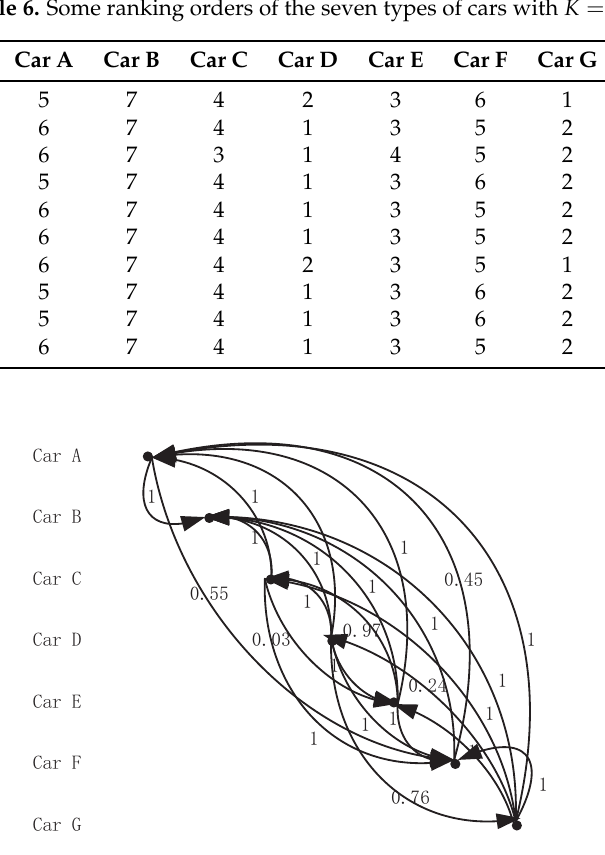
Figure 3. Dominance relationship diagram of seven cars.